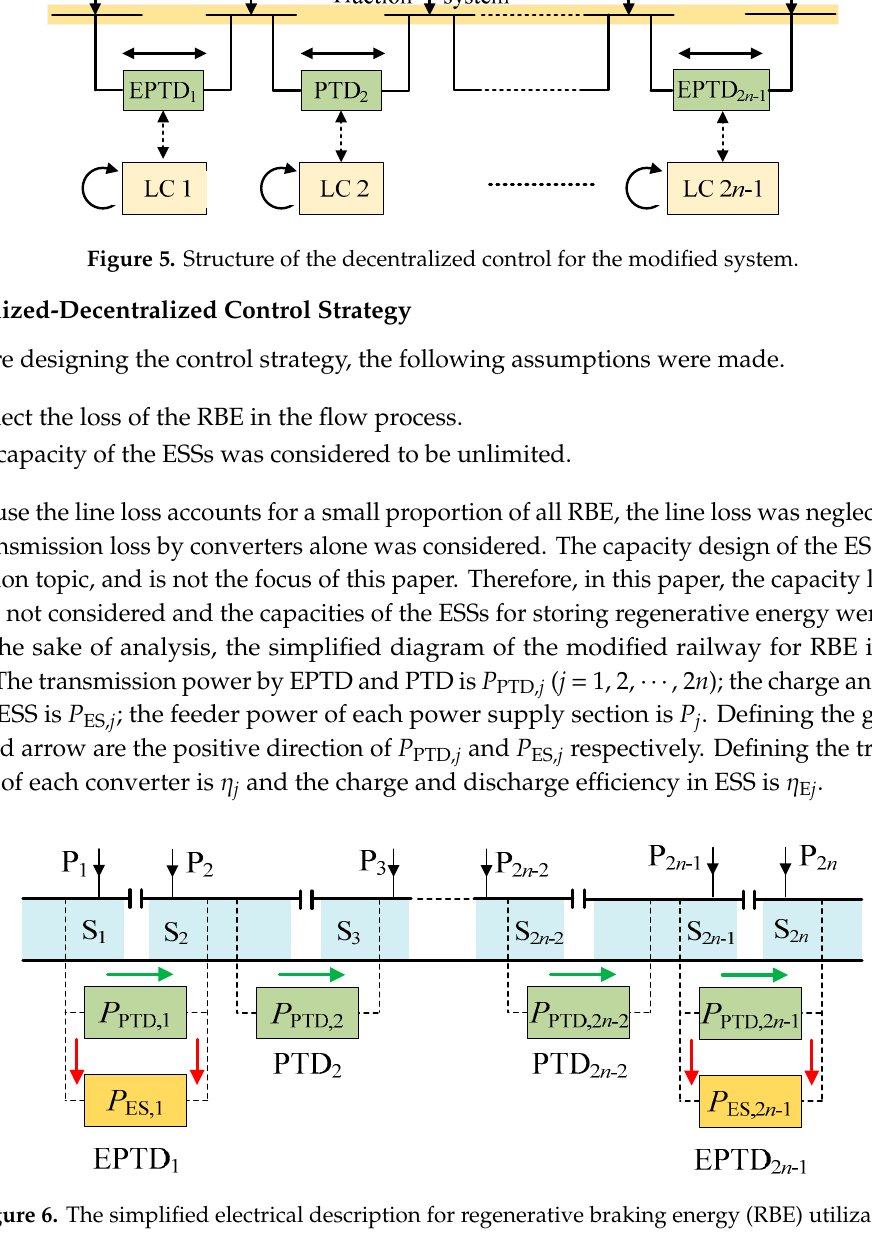
Figure 5. Structure of the decentralized control for the modified system.